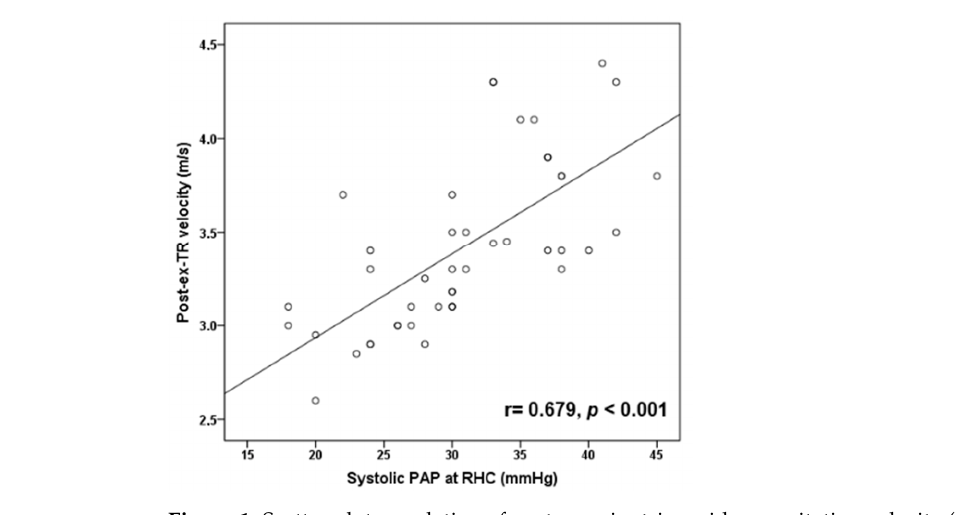
Figure 1. Scatter plot correlation of post-exercise tricuspid regurgitation velocity (post-ex-TR velocity) with resting systolic pulmonary arterial pressure (PAP) at right-heart catheterization (RHC).